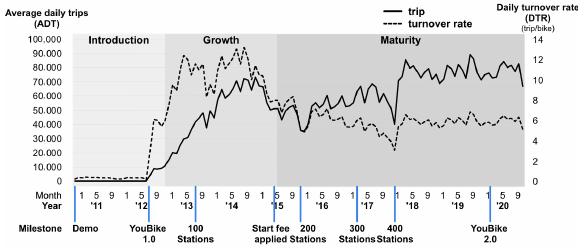
Fig. 2. Longitudinal daily trips and turnover